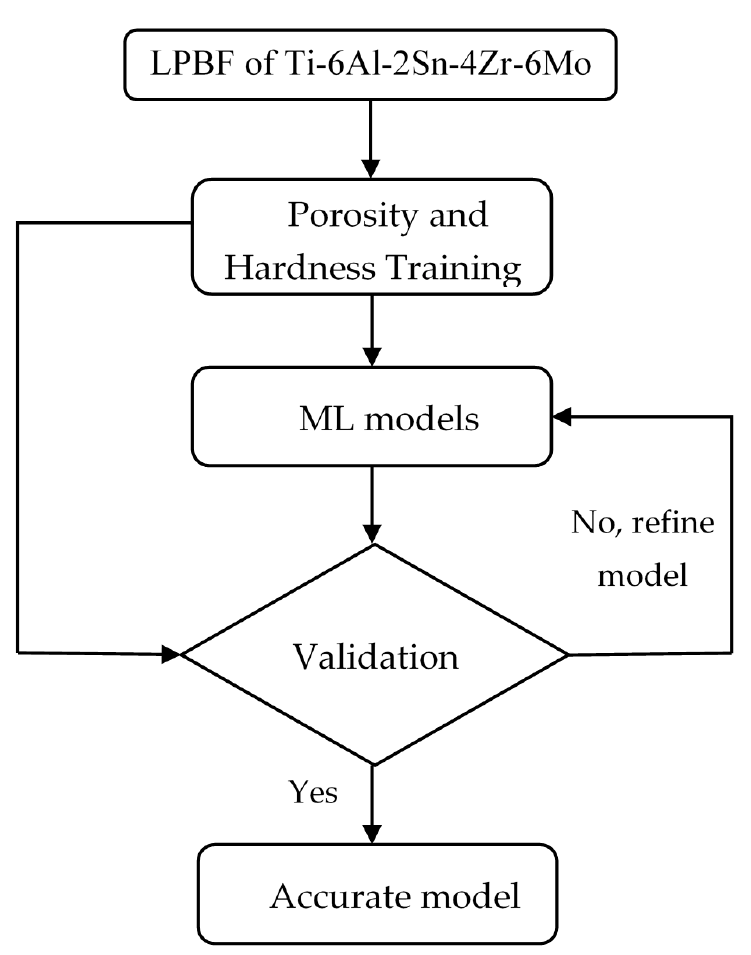
Figure 1. The flow diagram of the processing and modelling procedure.